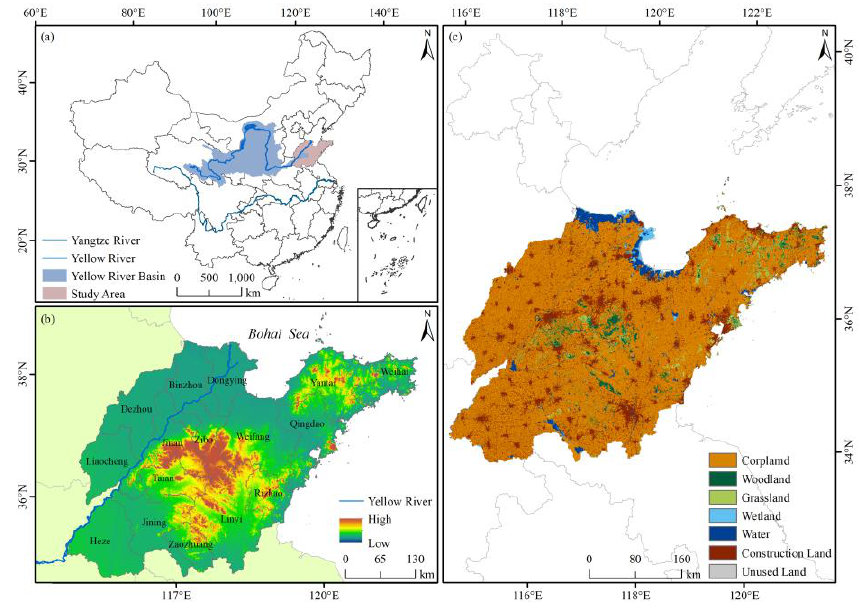
Figure 1. Study area locations. ( a ) Location of the study area in China; ( b ) elevation of the study area; ( c ) land use distribution map of the study area. ( c ) land use distribution map of the study